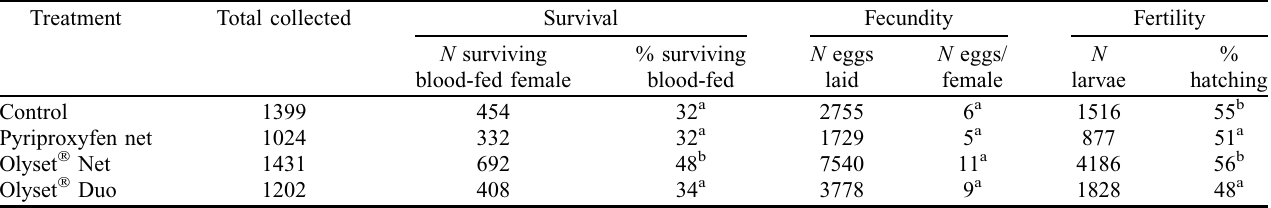
N : number; For each parameter, values in columns sharing the same superscript letter are not significantly different ( p > 0.05) according to Negative Binomial regression (fecundity) or logistic regressions (survival and fertility).